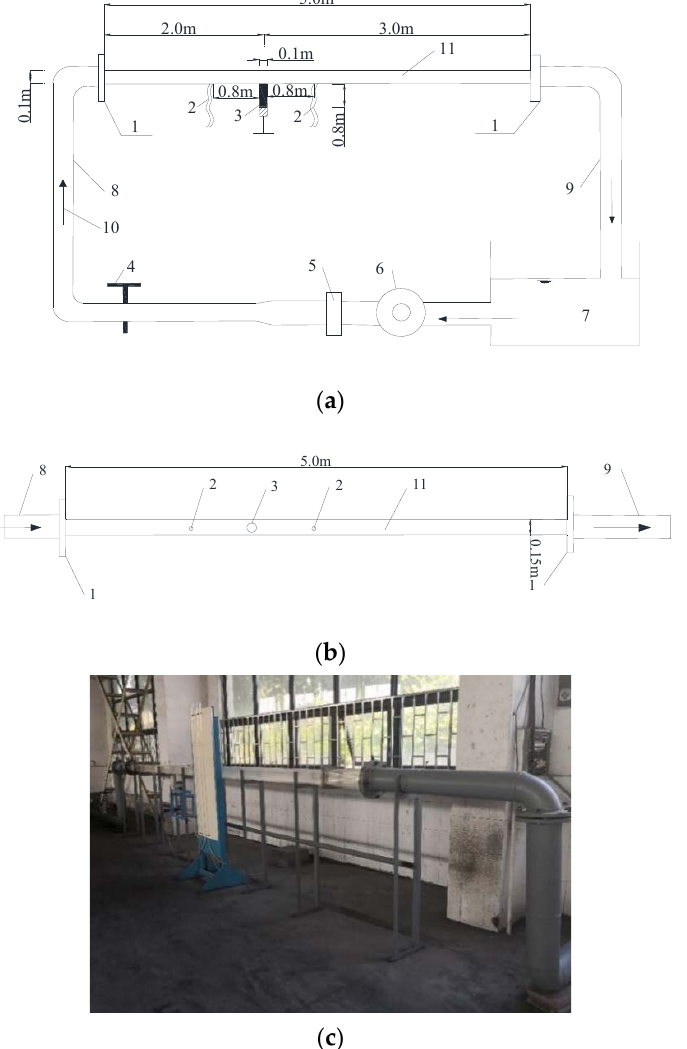
Figure 4. The overall structure of the flume: 1—flange; 2—piezometer; 3—top soil device; 4—valve; 5—electromagnetic flowmeter; 6—water pump; 7—reservoir; 8—water inlet; 9—water outlet; 10—water flow direction; 11—flume. ( a ) Elevation, ( b ) Plan, ( c ) Flume.